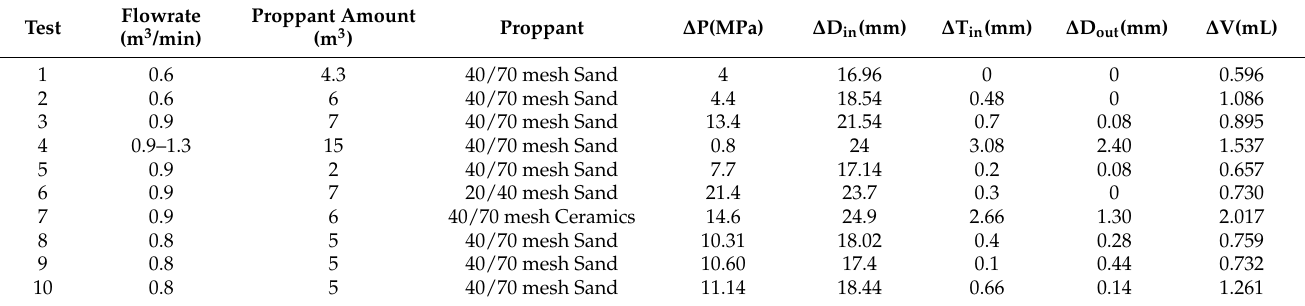
Table 2. Measurement results of perforation erosion parameters for tests